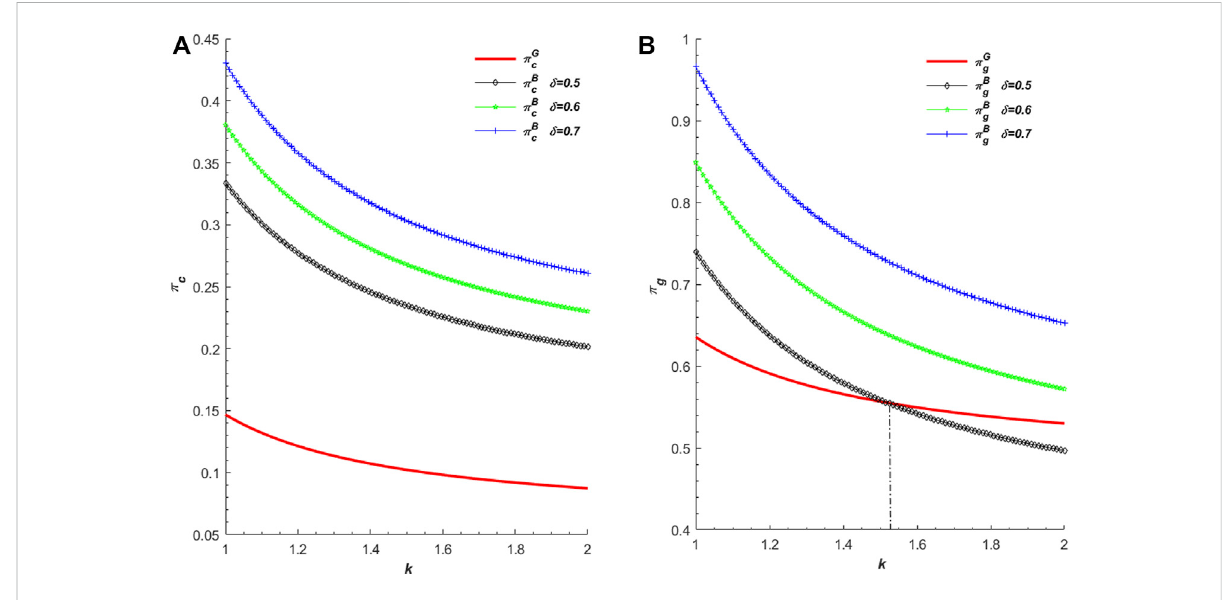
FIGURE 3 Effects of δ on (A) consumer surplus and (B) social welfare.